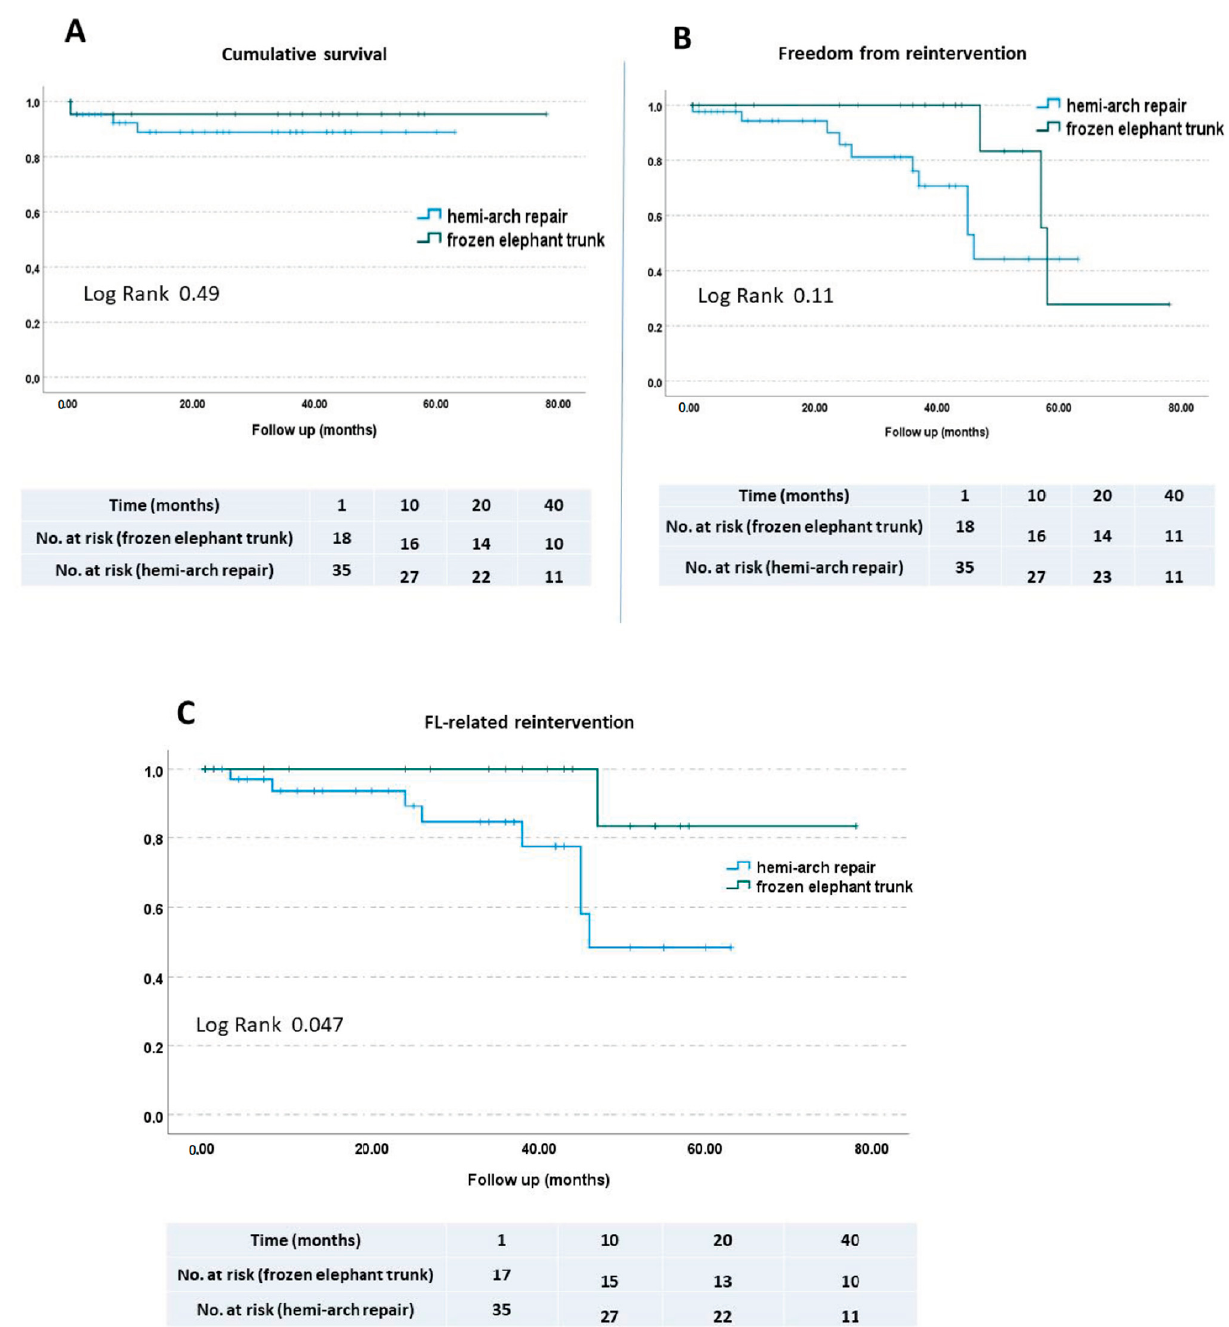
Figure 3. Kaplan–Meier survival and re-intervention estimates showed no significant differences between the groups ( A , B ). ( C ) Patients in the hemi-arch repair group have a significant difference for FL-related re-intervention.